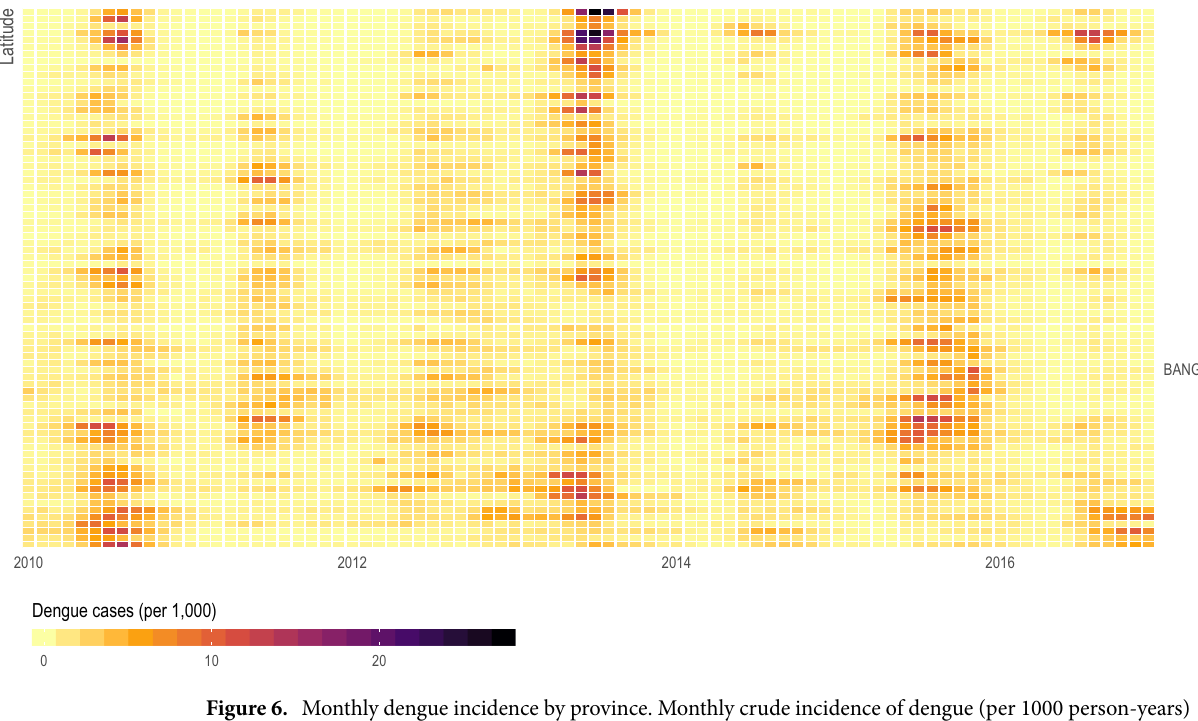
Figure 6. Monthly dengue incidence by province. Monthly crude incidence of dengue (per 1000 person-years) by province (y-axis) ordered by centroid latitude (higher is more northern) over 7 years of observation (x-axis). Dengue in Thailand follows a seasonal cycle with geographic variation in both the timing of onset and peak of the epidemic.